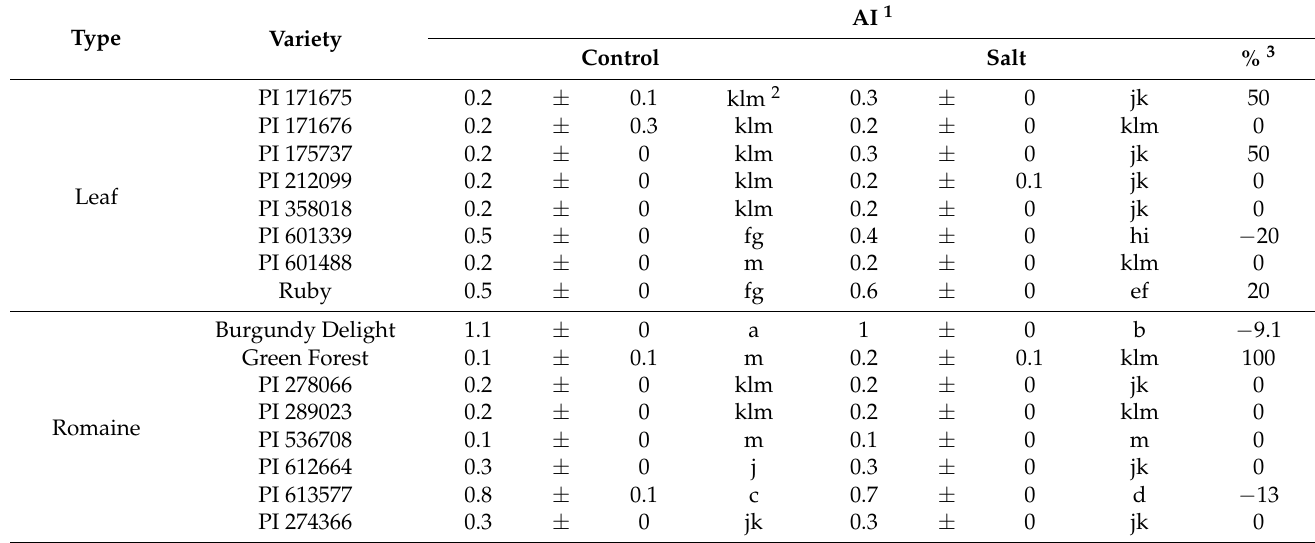
1 Anthocyanin index on per plant basis. 2 Means followed by different letters are significantly different from each other ( p < 0.05) as assessed by Tukey’s test. 3 % indicates the percentage change in each variety due to change in treatment levels (Control vs. Salt), where negative sign ( − ) indicates a percentage decrease in AI.